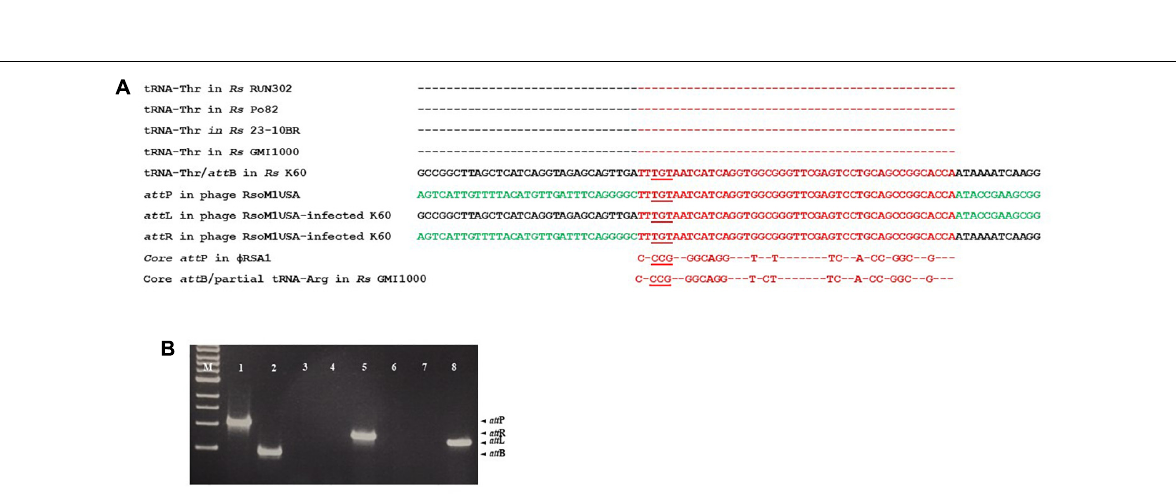
FIGURE 5 | Integration of Ralstonia phage RsoM1USA into the genome of R. solanacearum strain K60. (A) Comparison of the attachment ( att ) sequences. The att B sequence of R. solanacearum strain K60 (before phage RsoM1USA integration) contains the same 76-bp threonine (Thr) tRNA sequence found in R. solanacearum strains RUN302, P082, 10-23BR, and GMI1000 (the same amino acid is indicated by “–”). The att B sequence in R. solanacearum strain K60 was aligned with the tRNA-threonine-like att P sequence in Ralstonia phage RsoM1USA. The 54-bp core att sequence is shown in red. The sequences after integration of phage RsoM1USA into R. solanacearum strain K60 ( att L and att R) are shown. Sequences from the bacterial strain K60 and the phage RsoM1USA are shown in black and green, respectively. The core att P sequence of phage RsoM1USA was also compared to that of phage RSA1 which matched the 3 (cid:48) arginine (Arg) tRNA in R. solanacearum strain GMI1000 (Fujiwara et al., 2008). Only nucleotides different from phage RsoM1USA’s core att P sequence were shown. The anticodons of threonine (TGT) and arginine (CCG) tRNAs are underlined. Rs : R. solanacearum . (B) Amplification of att regions by PCR and separation by gel electrophoresis. The 1,068-bp att P and 452-bp att B fragments were amplified from DNA of phage RsoM1USA (lane 1) and R. solanacearum strain K60 (lane 2), respectively. The 800-bp att R and 720-bp att L fragments were detected only from DNA of phage RsoM1USA-infected strain K60 (lanes 5 and 8) after integration, but not from phage RsoM1USA (lanes 3 and 6) and strain K60 (lanes 4 and 7). M: 1-kb DNA